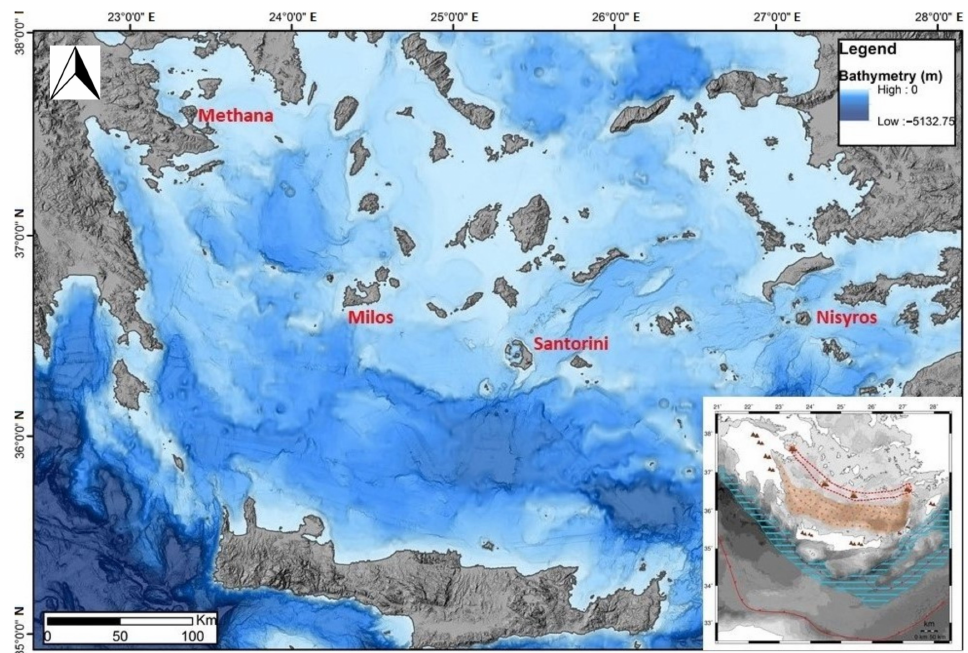
Figure 1. Synthetic Topographic Map of the South Aegean Sea depicting the islands of the SAVA. Inset map: Map of the HSS where the East Mediterranean Chain (bottom grey area), the Hellenic trench (blue lines), the Island arc (red triangles), the Cretan Back-arc Basin (orange dots), and the SAVA (top red triangles) are indicated (modified from